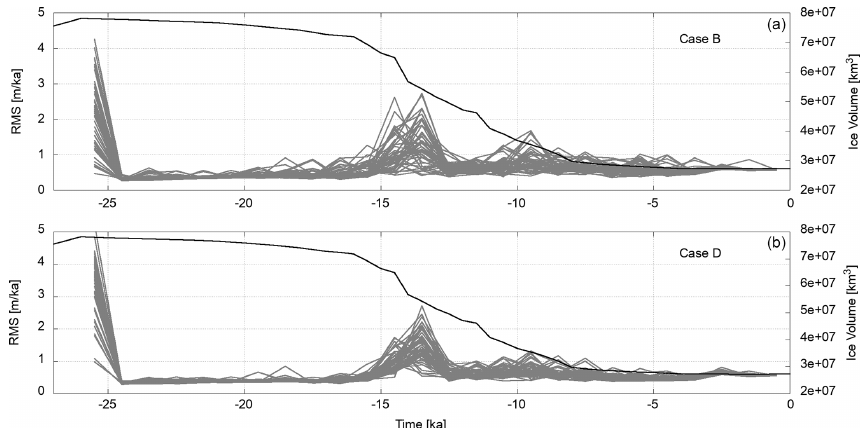
Figure 7. Measures of misfit variation for the ensemble of scenario two in set-up 1 (Cases B and D) in grey. Shown are the RMS values of the difference between the observations and the model predictions. The black lines show the total ice volume according to the external ice